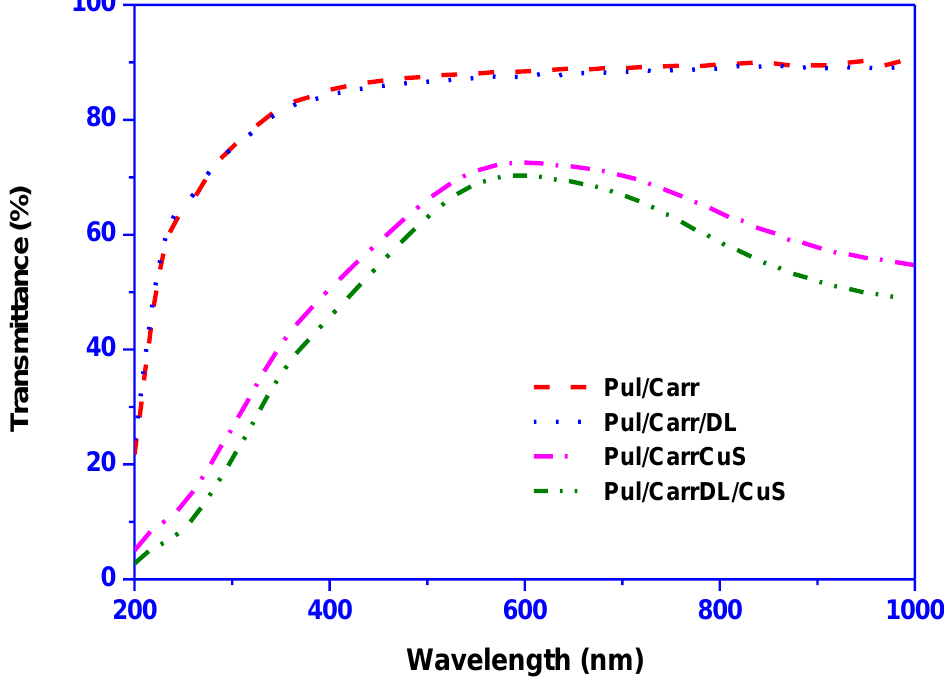
Figure 2. Light transmittance spectra of pullulan/carrageenan-based films.